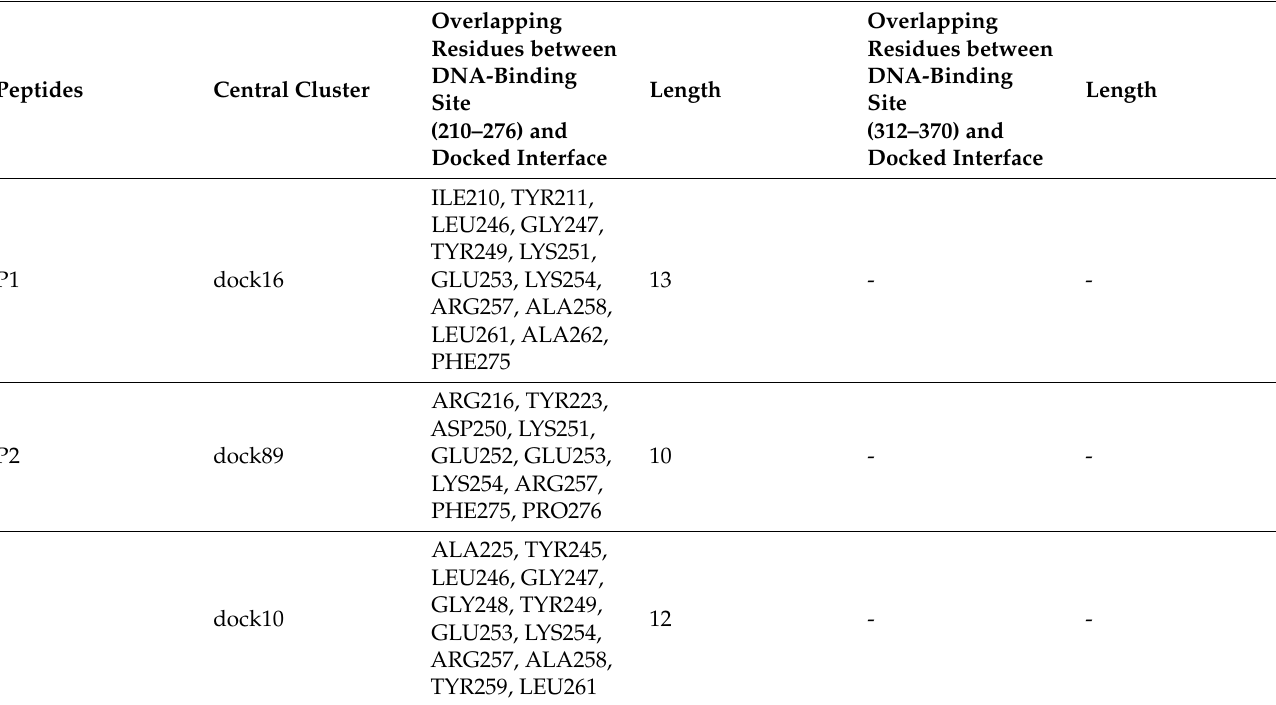
Table 7. Peptides and the corresponding residues of the BBM protein at the interface overlapped with the DNA binding